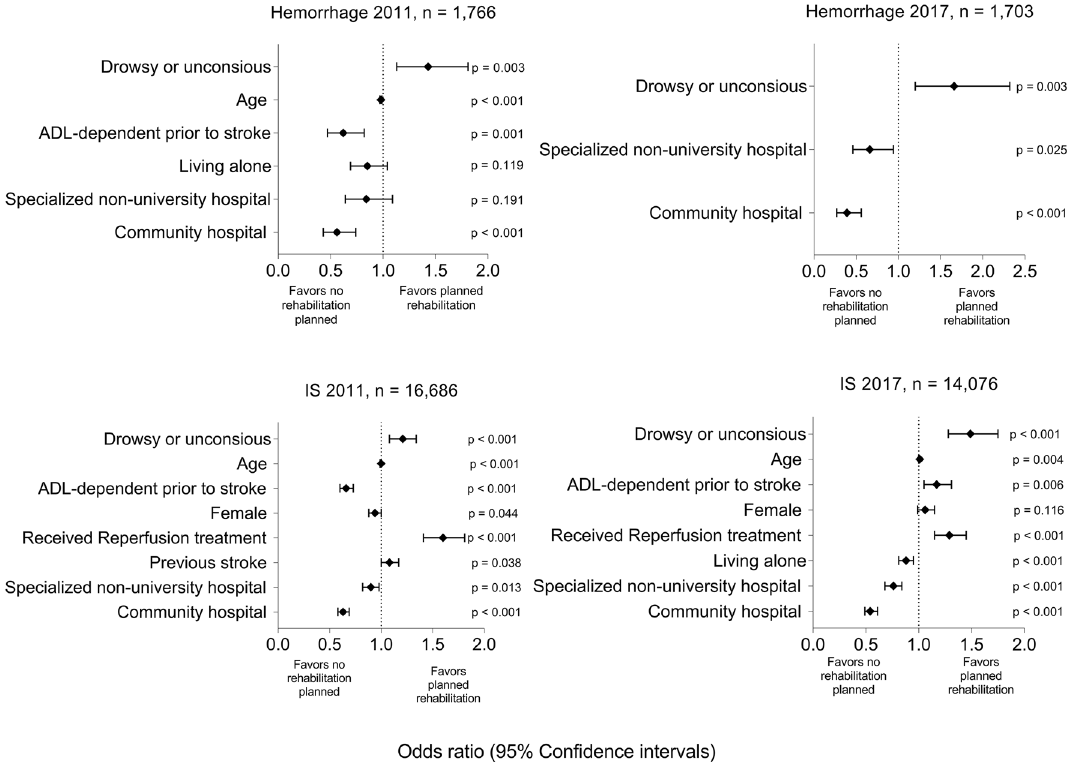
Figure 2. Deviation from the national mean for each of the 21 regions in Sweden regarding the percentage of patients receiving planned rehabilitation at discharge from a stroke unit. Regions with higher frequency than the national mean are shown on the positive X-axis while regions with lower frequency are shown on the negative X-axis. *Indicates regions with a change in frequency of planned rehabilitation of 30 percentage points or more between 2011 and 2017. IS ischemic